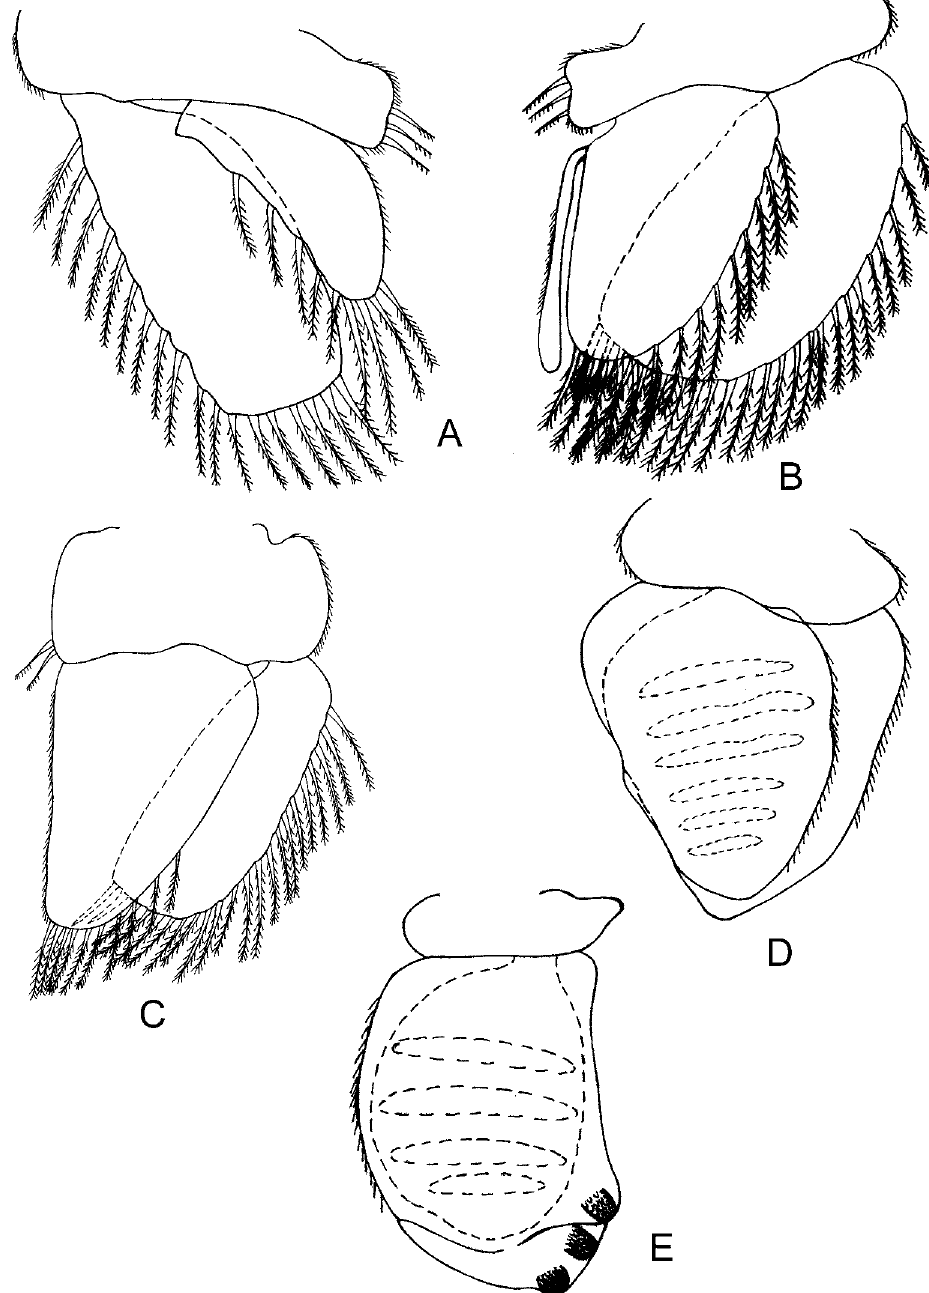
Figure 6. Sphaeromopsis jayaraji sp. nov., holotype male (2.9 mm) (PUMB 35104). A , pleopod 1; B , pleopod 2; C , pleopod 3; D , pleopod 4; E , pleopod